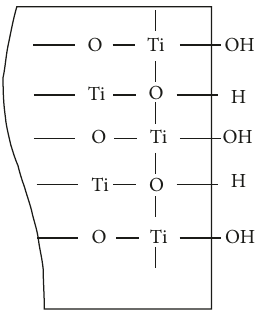
Figure 8: Schematic diagram of TiO 2 surface adsorbed hydroxyl.